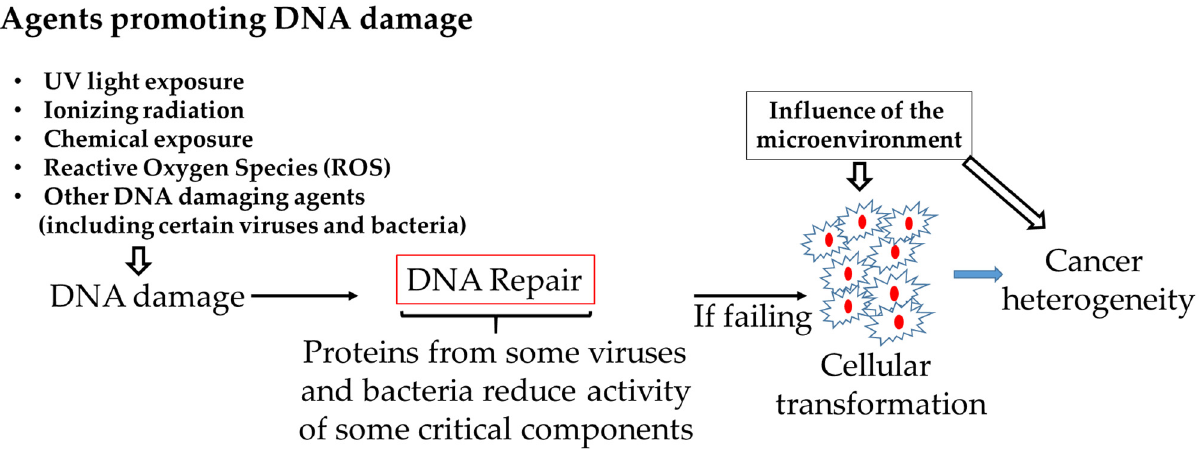
Figure 1. Proteins from some viruses and bacteria may promote cellular transformation by reducing the activity of cellular pathways involved in DNA repair.